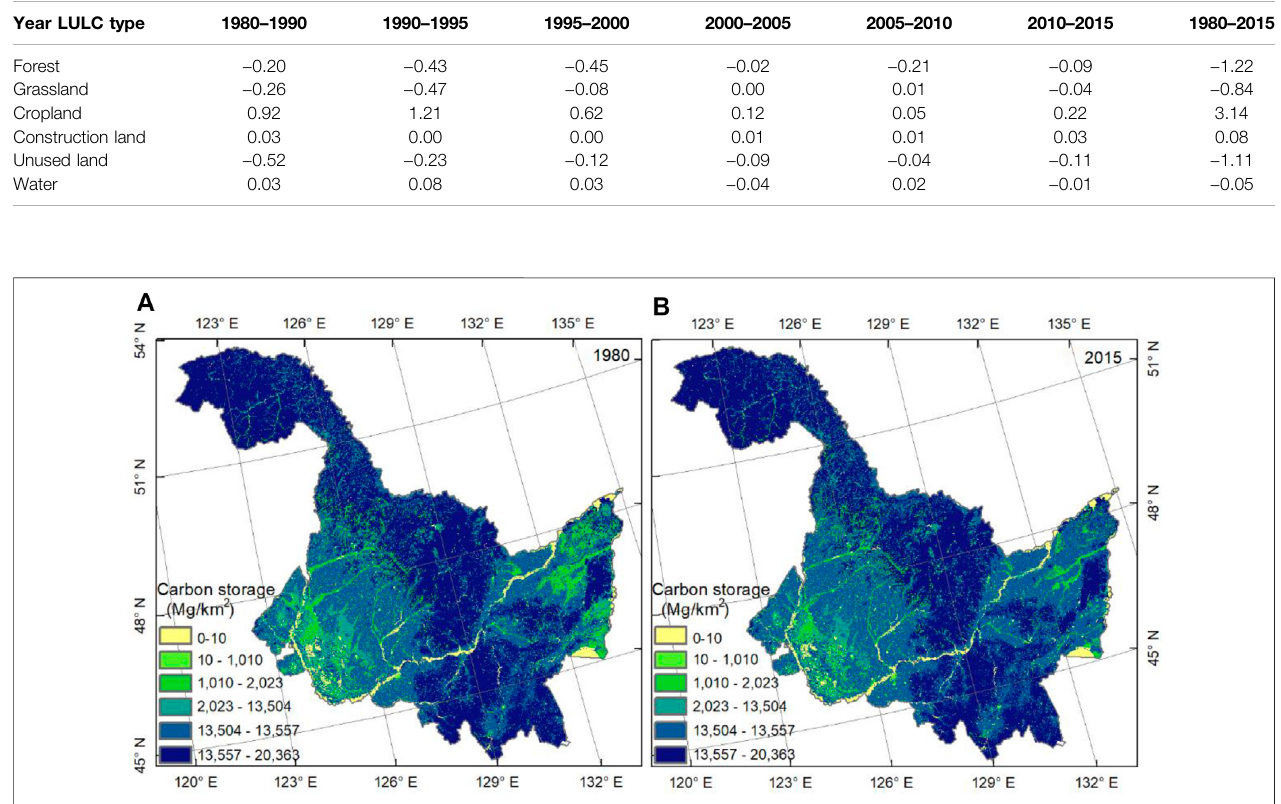
FIGURE 4 | Changes in carbon storage of Heilongjiang Province, Northeast China in 1980 and 2015.